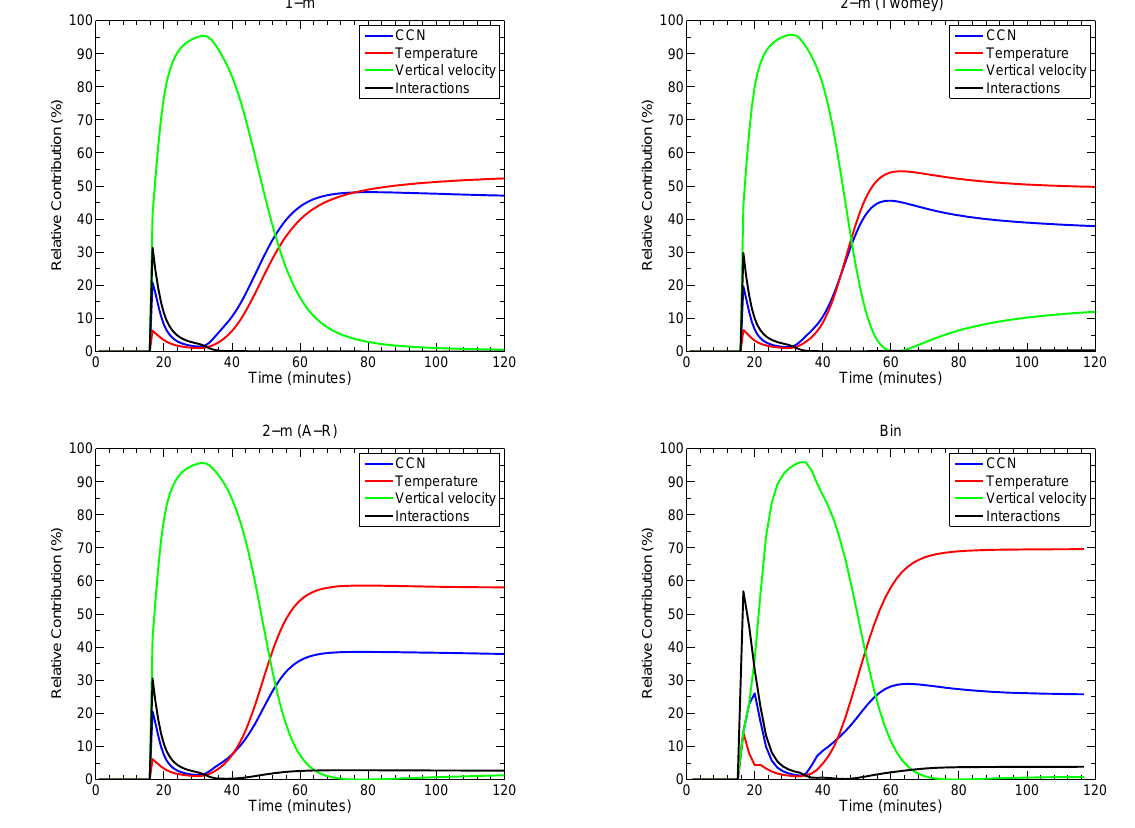
Fig. 9. Relative contribution (%) timeseries plots for each scheme, considering the effects of changes in CCN, w 1 and T , plus their combined interaction effects. The relative contribution is calculated as a percentage of the total variance associated with the change in precipitation at the surface. The contributions shown are based on the following changes: w 1 from 0.5ms − 1 to 2ms − 1 ; CCN from 50/cc to 100/cc, and T from RICO to RICO-2. Clockwise from top left: 1-m, 2-m Twomey, bin, 2-m A-R. 44